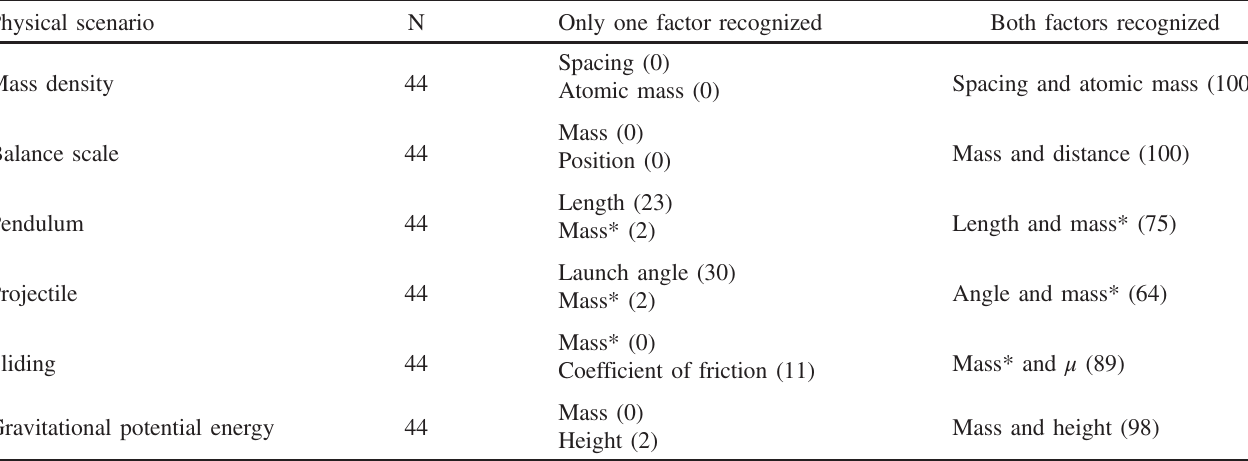
TABLE IV. Experiment 1 recognize condition results. Percentages of participants that recognize that various given factors or combinations of factors can explain given outcomes are in parentheses. Note that the factors with asterisks are not physically correct.